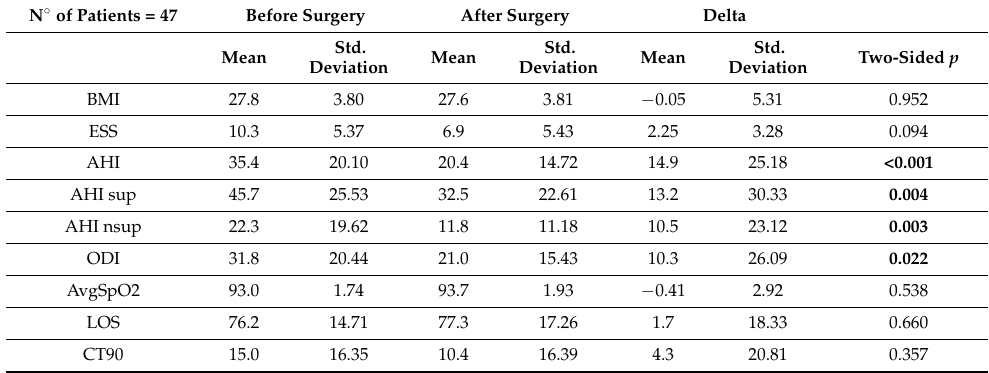
Table 1. Preoperative and postoperative data of our series (delta = preoperative–postoperative values) and paired t -test between preoperative and postoperative data are shown. N ◦ of Patients = 47 Before Surgery After Surgery Delta Mean Std. Deviation Mean Std.